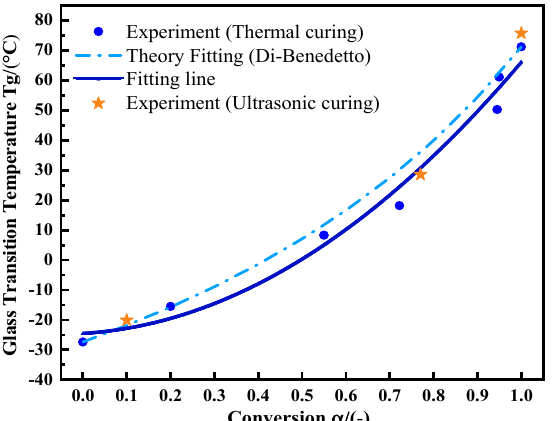
Figure 7. Curing rate versus curing degree of ultrasonic curing: heating rate of ( a ) 10 K/min; ( b ) 20 K/min. Table 4. Kamal autocatalytic model parameters of ultrasonic curing. Curing Kinetic Parameters Obtained with a Variable 𝑬 𝒂